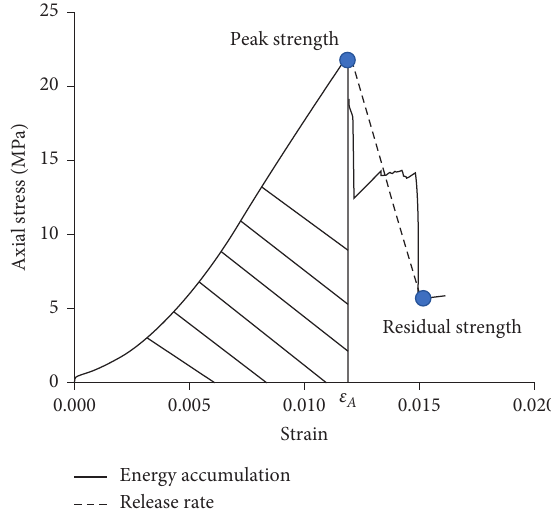
Figure 12: Mathematical model of calculation of energy accumulation and release